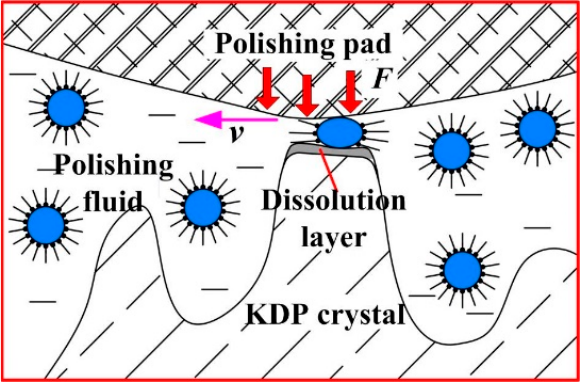
Figure 1. Illustration of the selective removal of material from a KDP crystal.